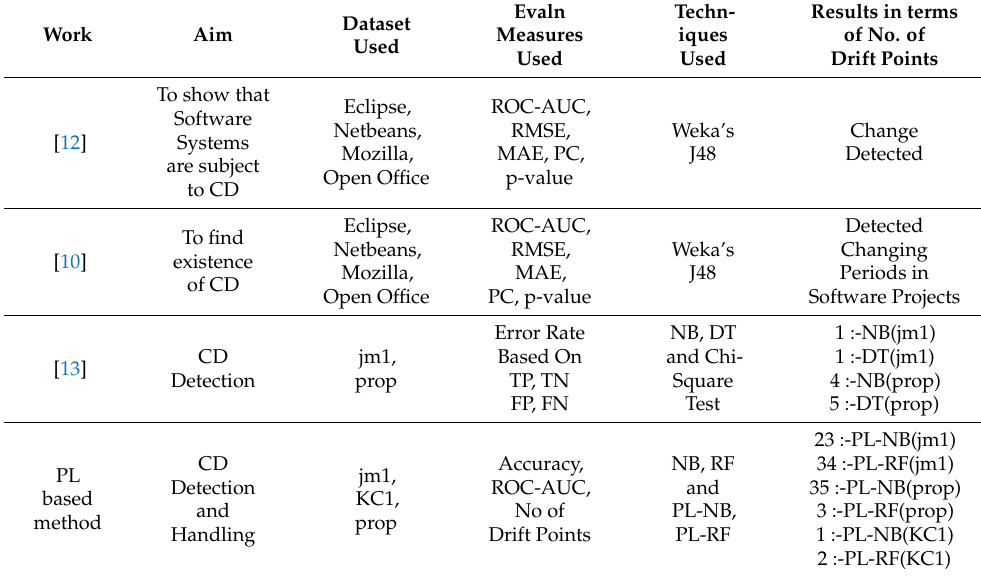
Table 9. Comparison with similar